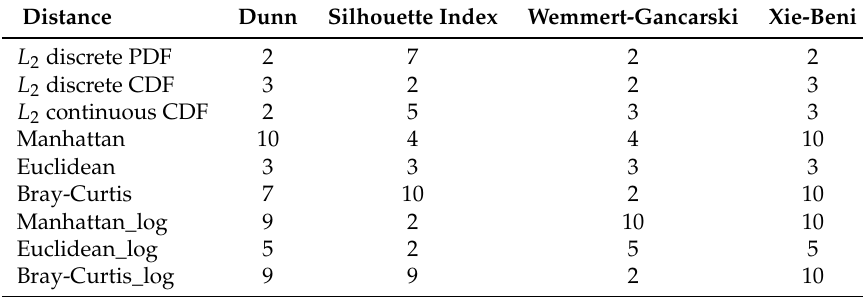
Table 3. Mean with standard deviation and median for OTUs that are significantly different ( p < 0.001) between two clusters using Dunn internal indices and L 2 -D PDF